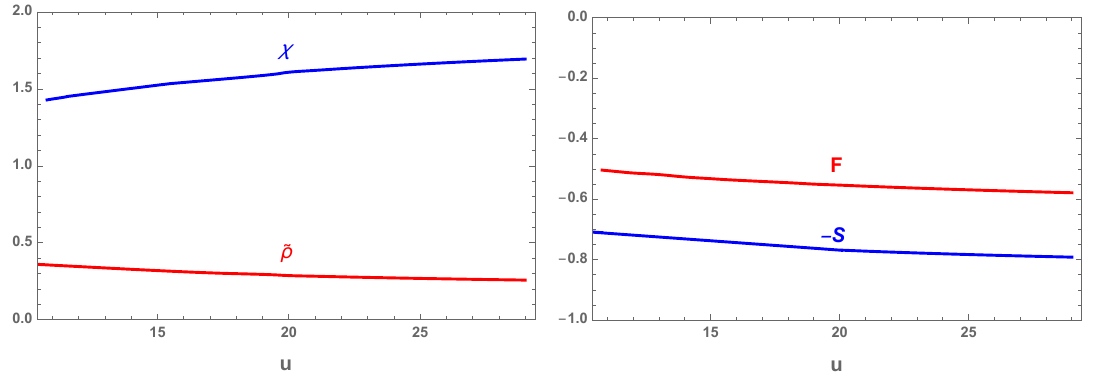
Figure 3 . The plot on the left shows the saddle-point solutions (cid:31) and ~ (cid:26) as functions of the input variable u . The plot on the right gives the values of the holy-grail function F = (cid:11) s (minus) instanton action (cid:0)S ( (cid:31) ) as functions of u